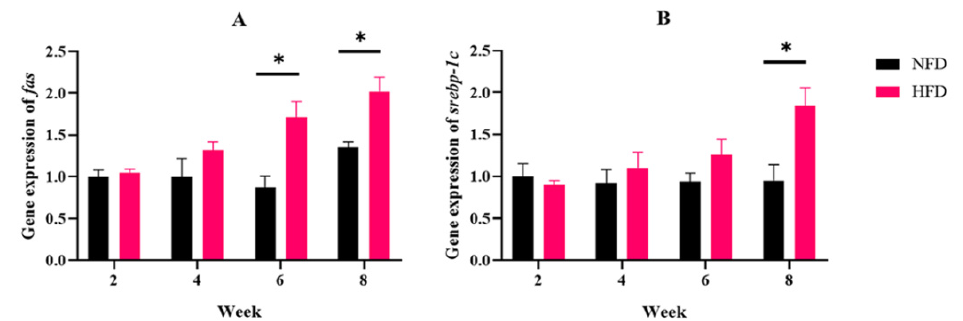
Figure 3. Experiment I. The expressions of fat metabolism-related genes in the liver. ( A ) Gene expression of fas . ( B ) Gene expression of srebp-1c . “*” indicates a significant difference between groups ( p < 0.05, Student’s t -test, n = 3).